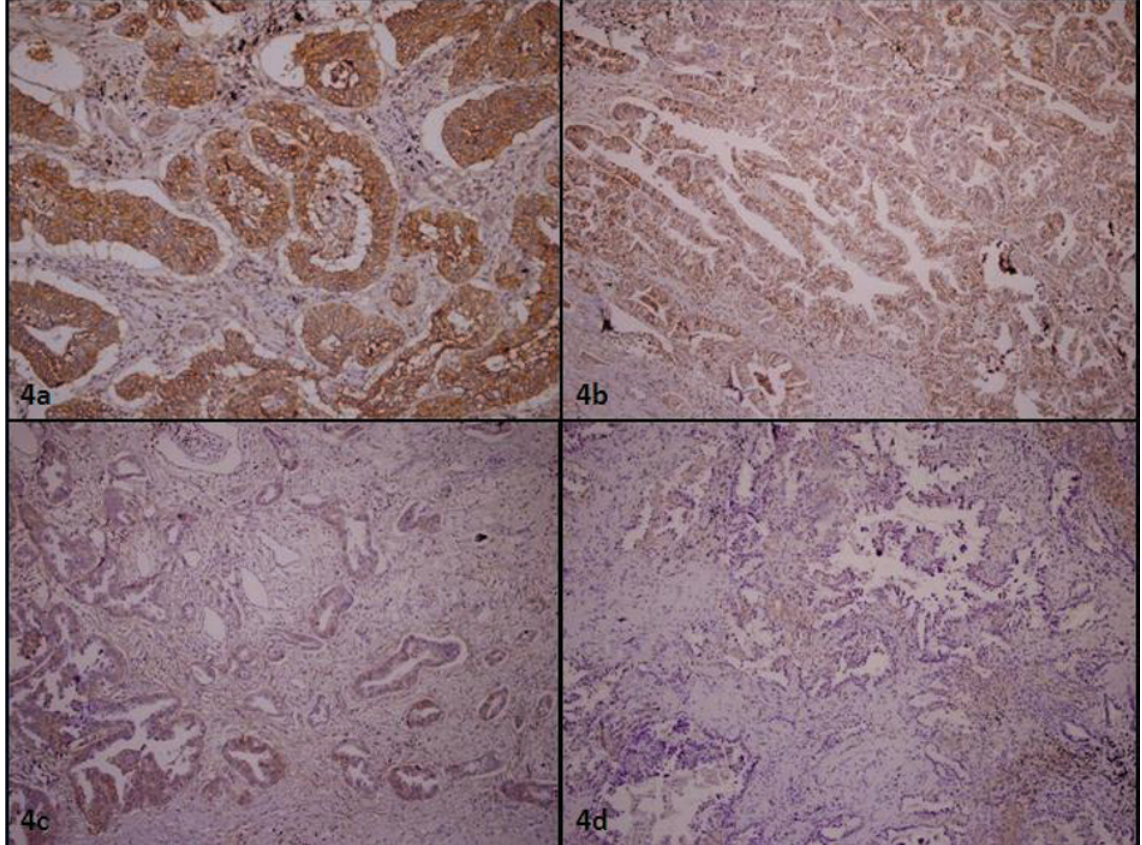
60% of tumor cells) and/or strong immunoreactivity are associated with shorter survival time of patients